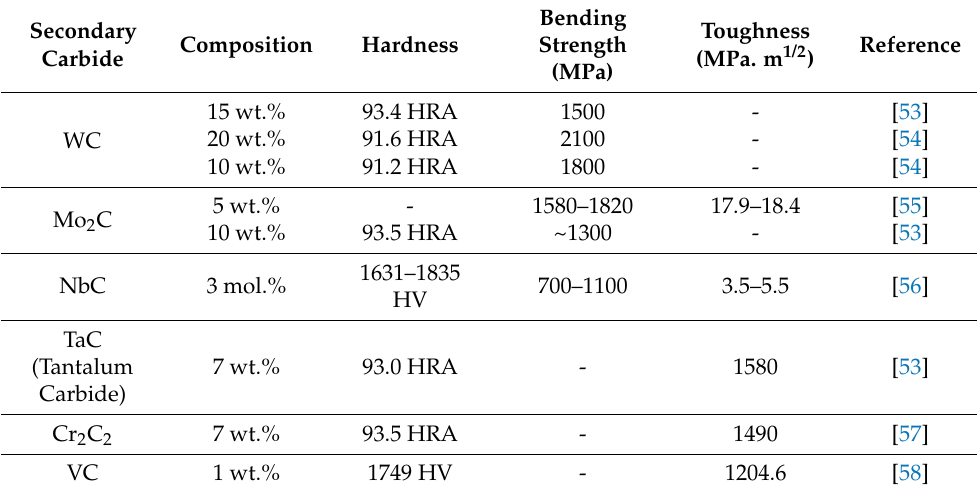
Table 3. Effect of secondary carbide addition on the mechanical properties of TiCN-based